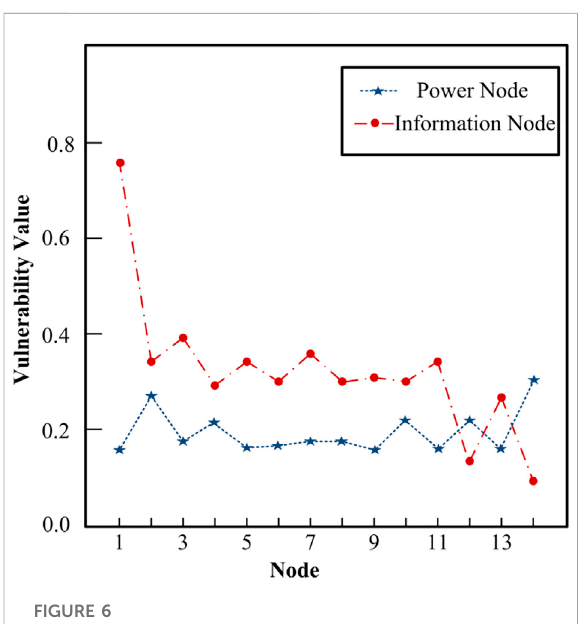
FIGURE 6 Node comprehensive vulnerability value.